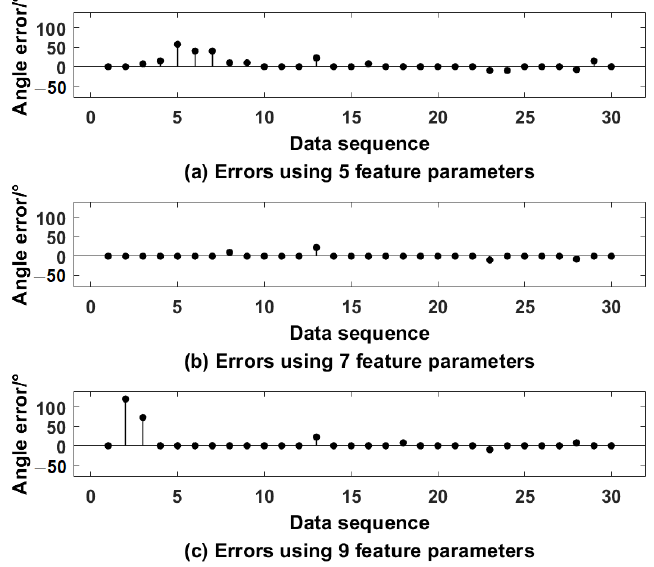
Figure 19. SVM angle prediction errors.